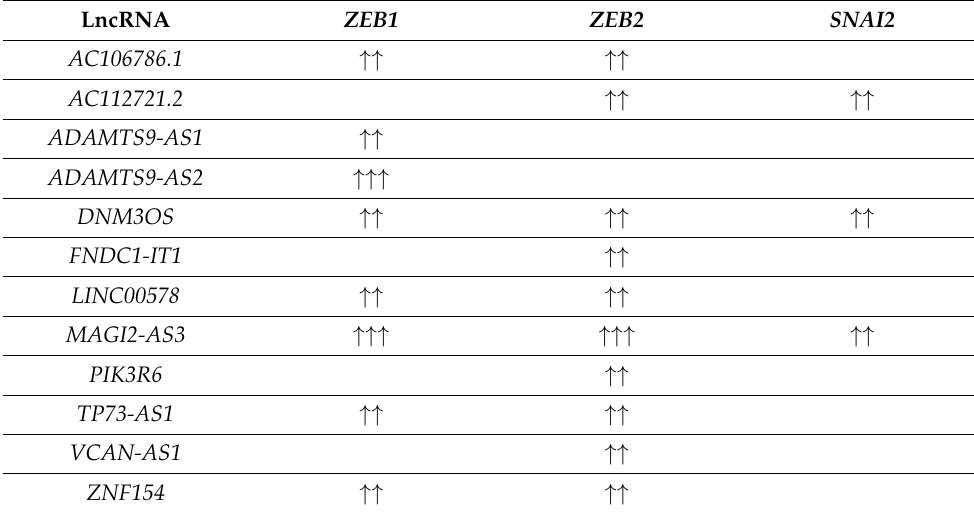
Table 4. Statistically significant correlations of selected lncRNAs and EMT-TFs in tumor of TCGA colon and rectum adenocarcinoma datasets. ↑↑↑ , very strong positive correlation; ↑↑ , strong posi- tive